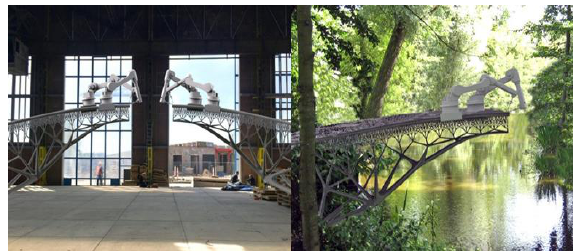
Figure 4 : Amsterdam’s new 3D-printed steel